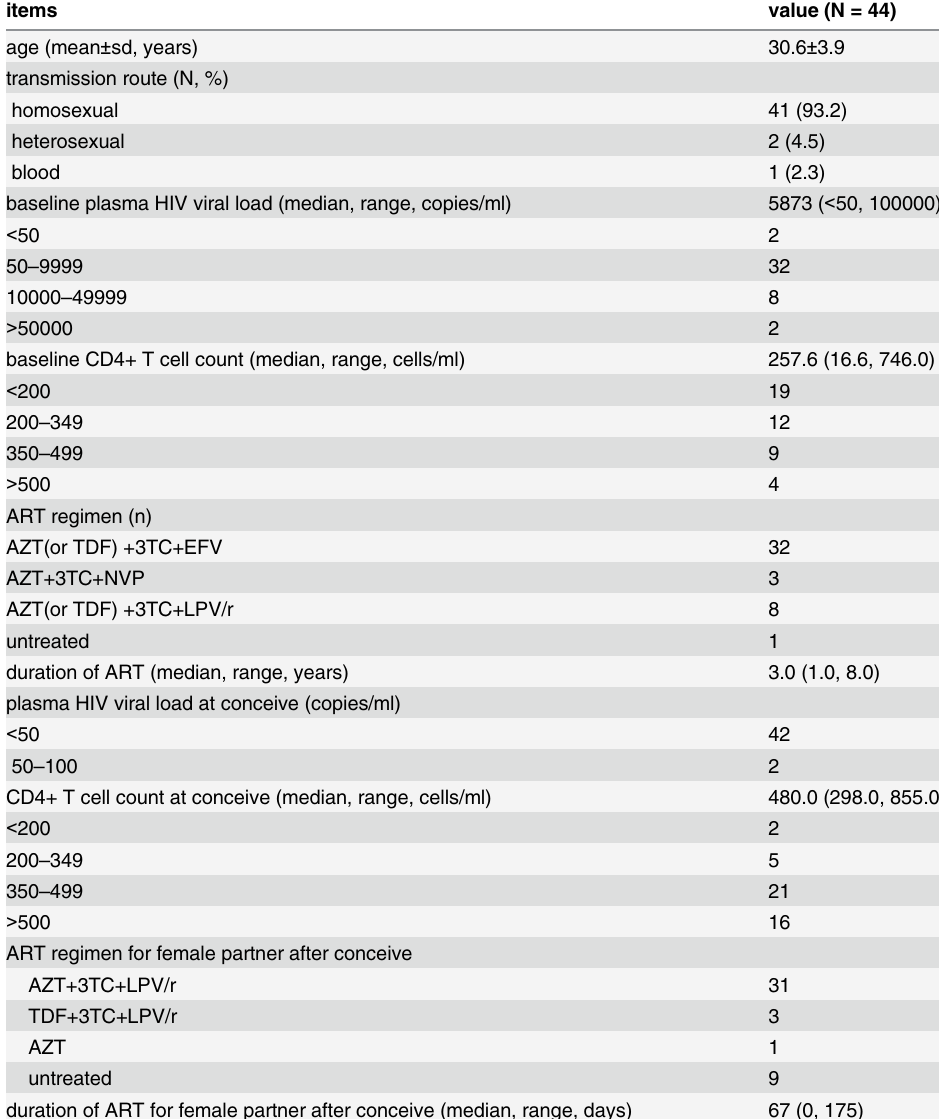
Table 1. The baseline characteristics of HIV positive men with female HIV negative partners.